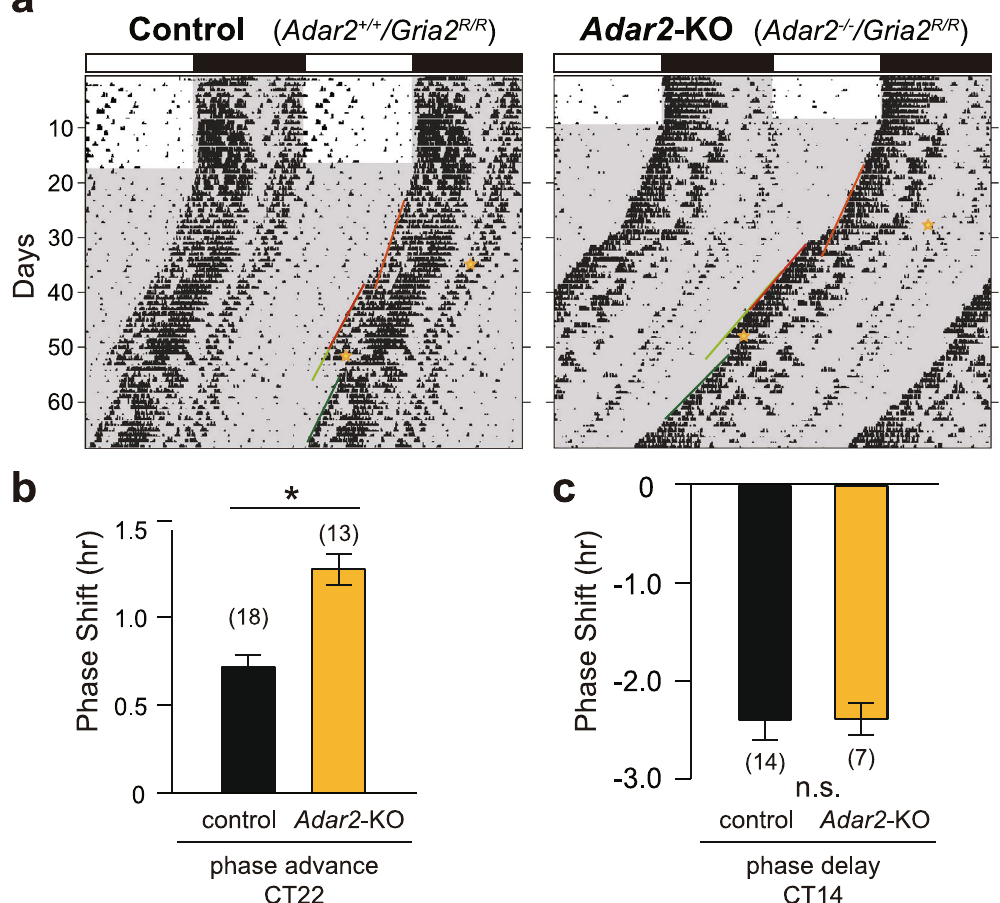
Figure 2. Effects of light pulses on the circadian phase at two different circadian times in Adar2 -KO mice. ( a ) Representative double-plotted actograms of wheel-running activity. The area with gray shading indicates the dark period. The light pulses (30 min, 300 lux) indicated by yellow stars were given first at CT22 and subsequently given at CT14. The red and green lines indicate the onset of activity used to calculate phase- advance and phase-delay of locomotor activity rhythms, respectively. ( b , c ) Phase-shift induced by a light pulse given at CT22 ( b ) or CT14 ( c ) (mean ± s.e.m.; n.s. P ≥ 0.05, * P < 0.05 by Student’s t -test). The numbers of animals are indicated in